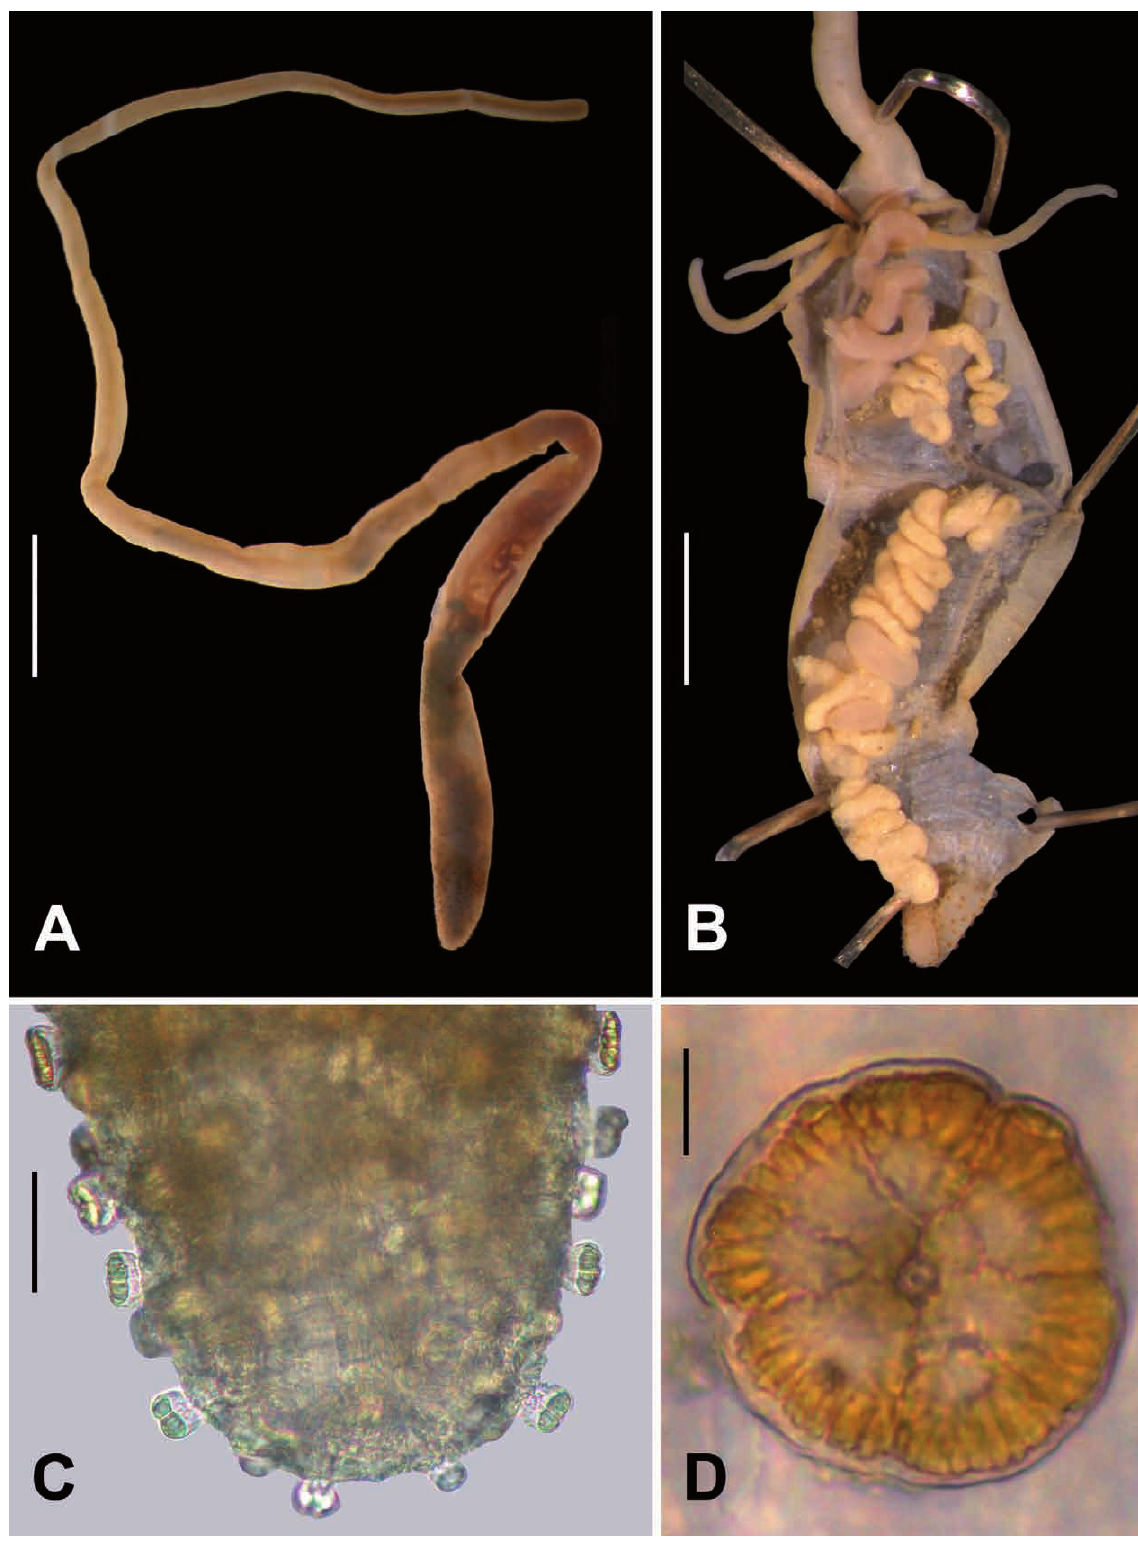
F IG . 2. – Apionsoma ( Apionsoma ) misakianum . A. Trunk and partly everted introvert of the specimen ESFM-SIP/2000-22, B. Internal anato- my of the specimen ESFM-SIP/2000-11, C. Small papillae on posterior part of the specimen ESFM-SIP/2000-11, D. Dorsal view of a papilla on posterior part of the specimen ESFM-SIP/2000-11. Scale bars: A = 2 mm, B = 1 mm, C = 100 µm, D = 12.5